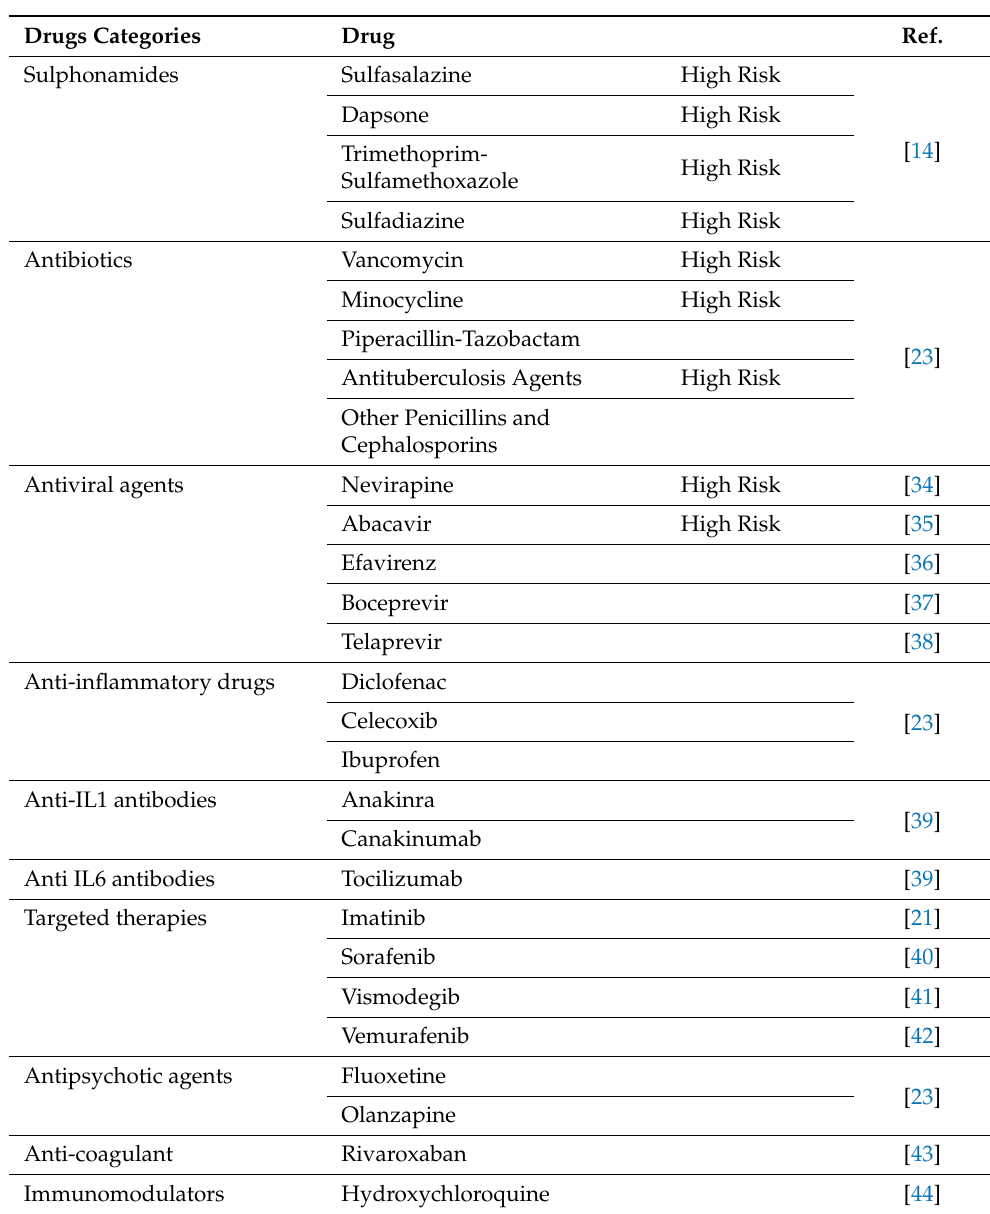
Table 1. Cont. Drugs